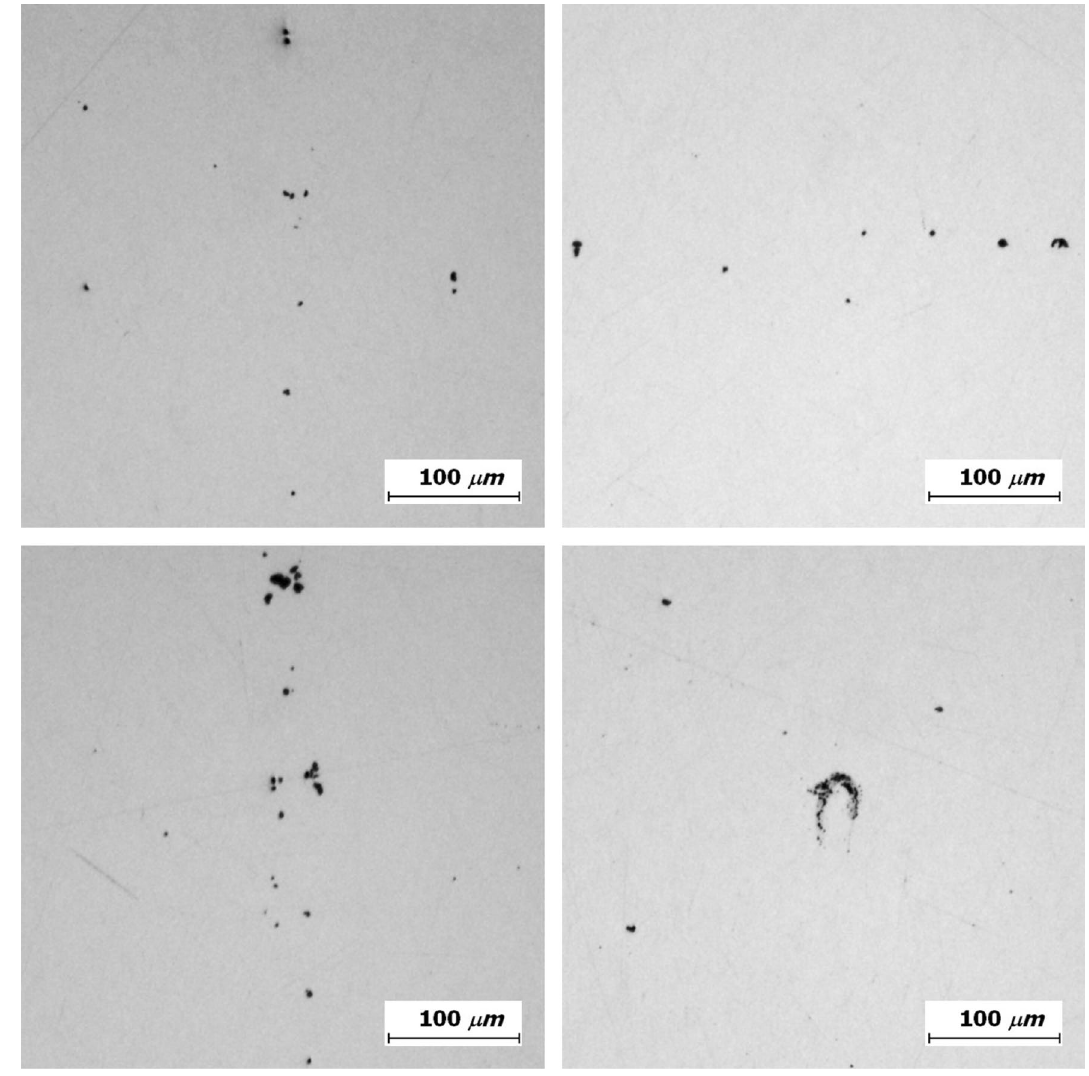
Figure 8. Optical microscopic images of typical inclusions in steel